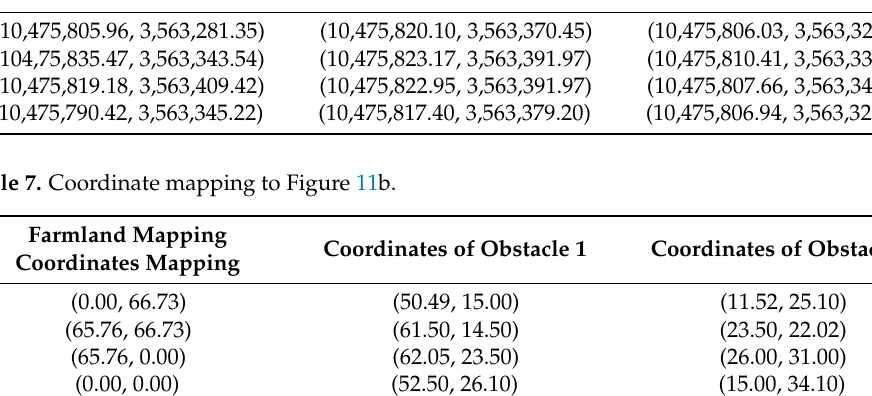
Table 6. Plane coordinates of Figure 11a. Plane Coordinates of Farmland Area Plane